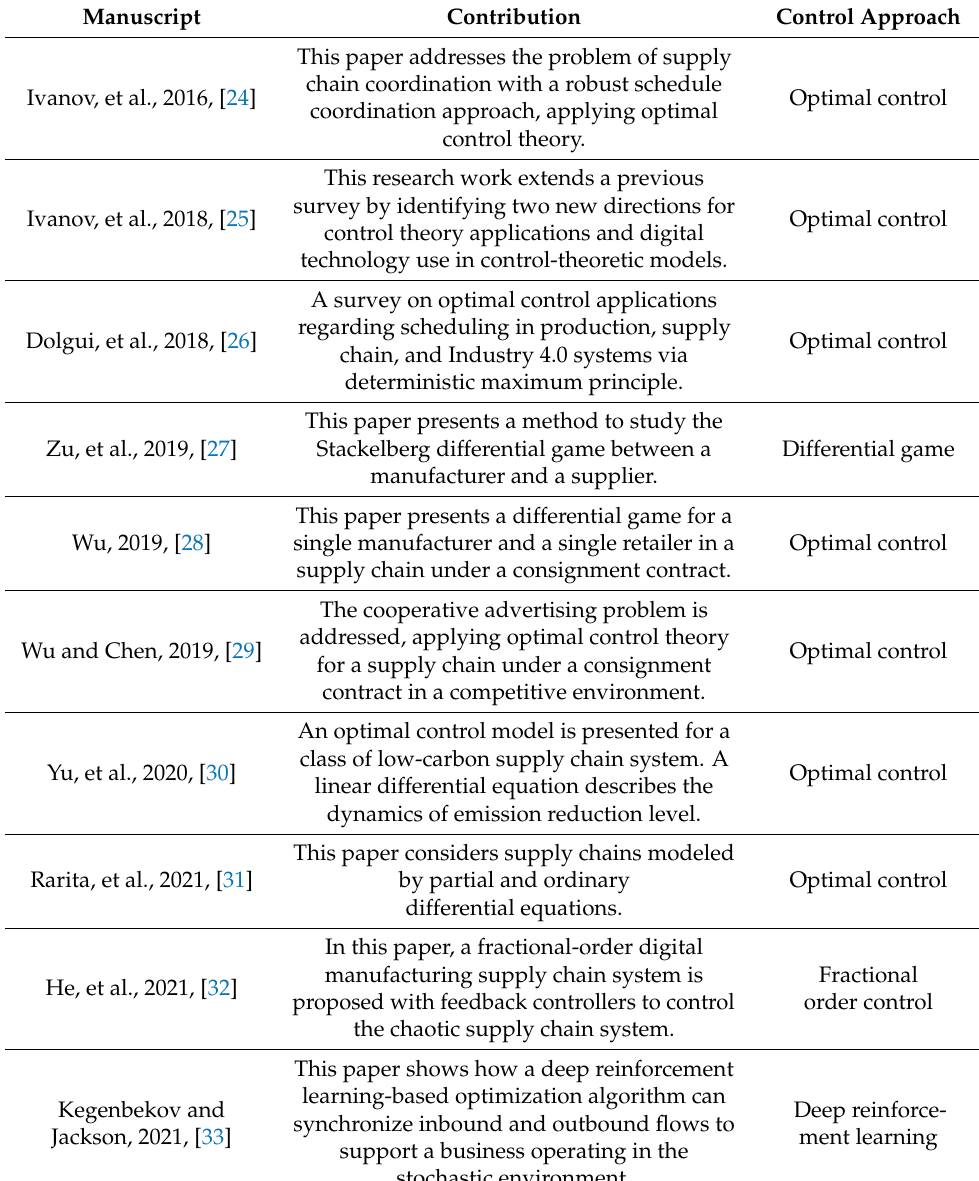
Table 1. Relevant optimal control for supply chains; literature review from 2016 to